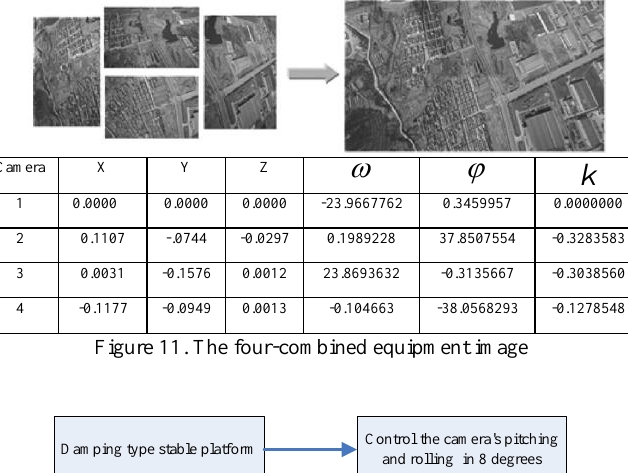
Figure 8. The view angle of single camera